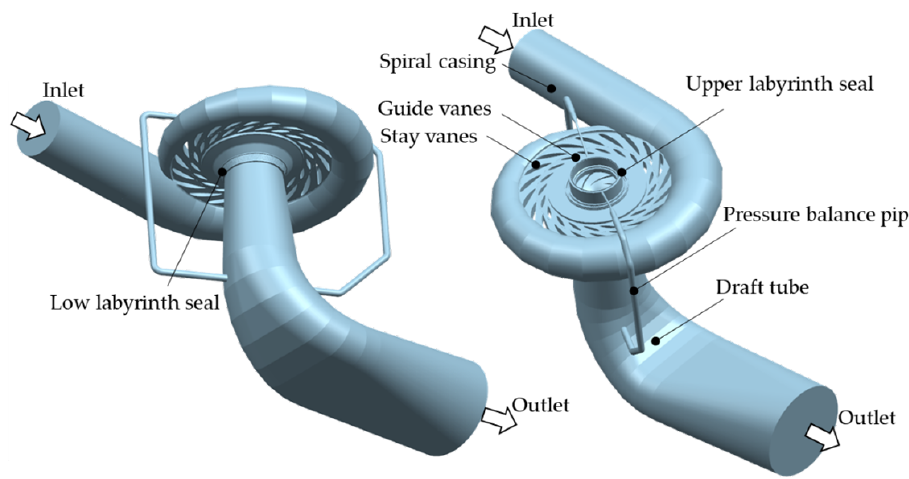
Figure 4. Fluid domain of the researched